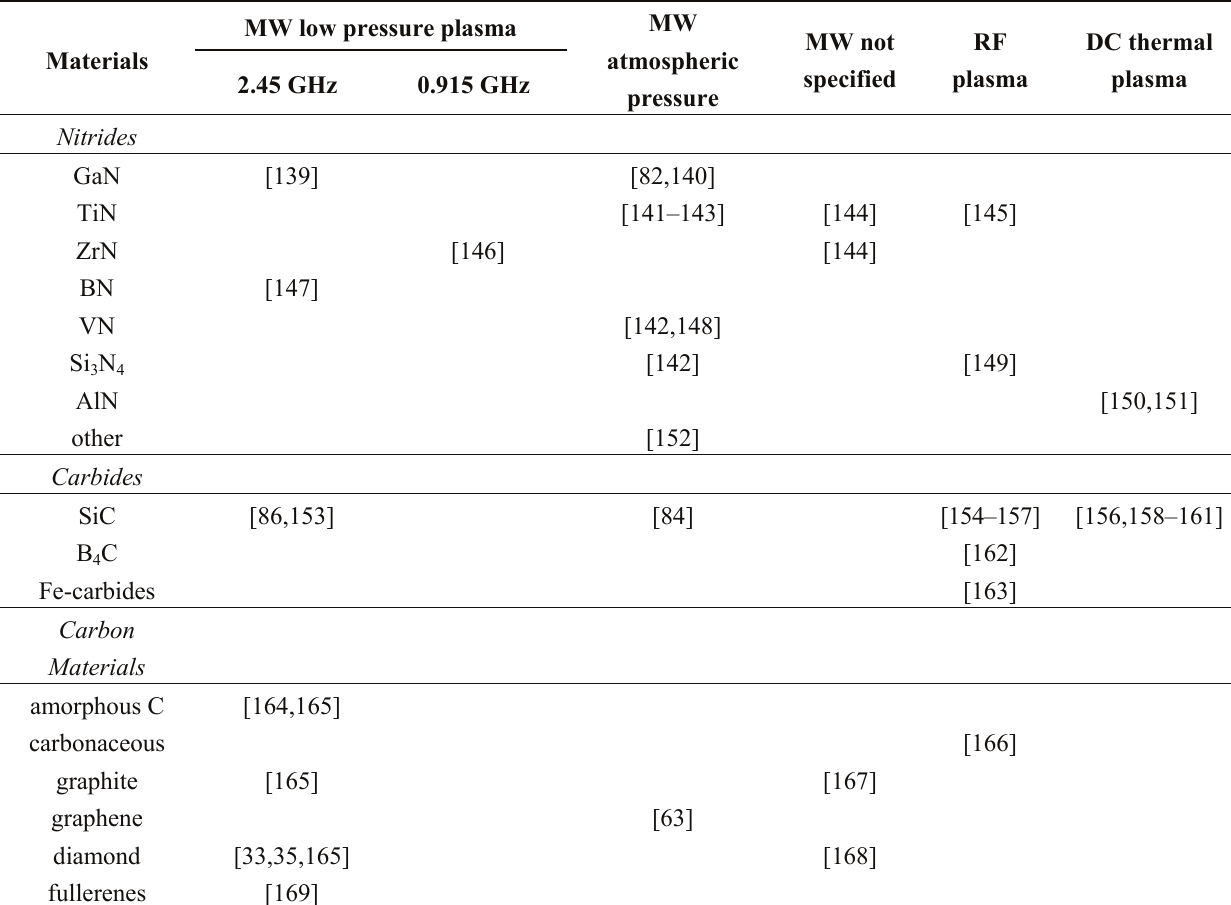
Table 3. Overview on published papers related to the subject of non-oxide nanoparticles, synthesized in microwave plasmas.